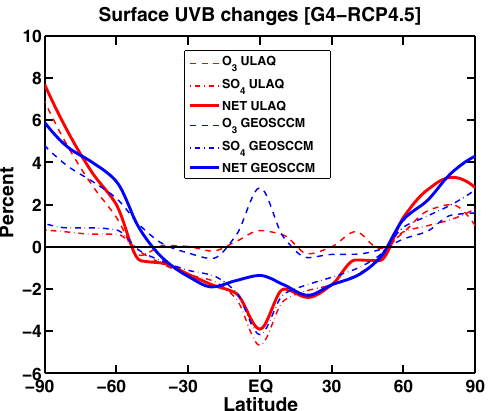
Figure 11. G4-RCP4.5 percent anomalies of surface UVB as a func- tion of latitude from ULAQ-CCM (c) (red) and GEOSCCM (blue) (2040–2049). UVB changes are shown for the two components that are explicitly online in the models (i.e., O 3 and aerosols) and for their net. ULAQ-CCM results are taken from numerical experi- ment (c) in Table 1 in order to make a more meaningful comparison with GEOSCCM, as in Fig. 9.